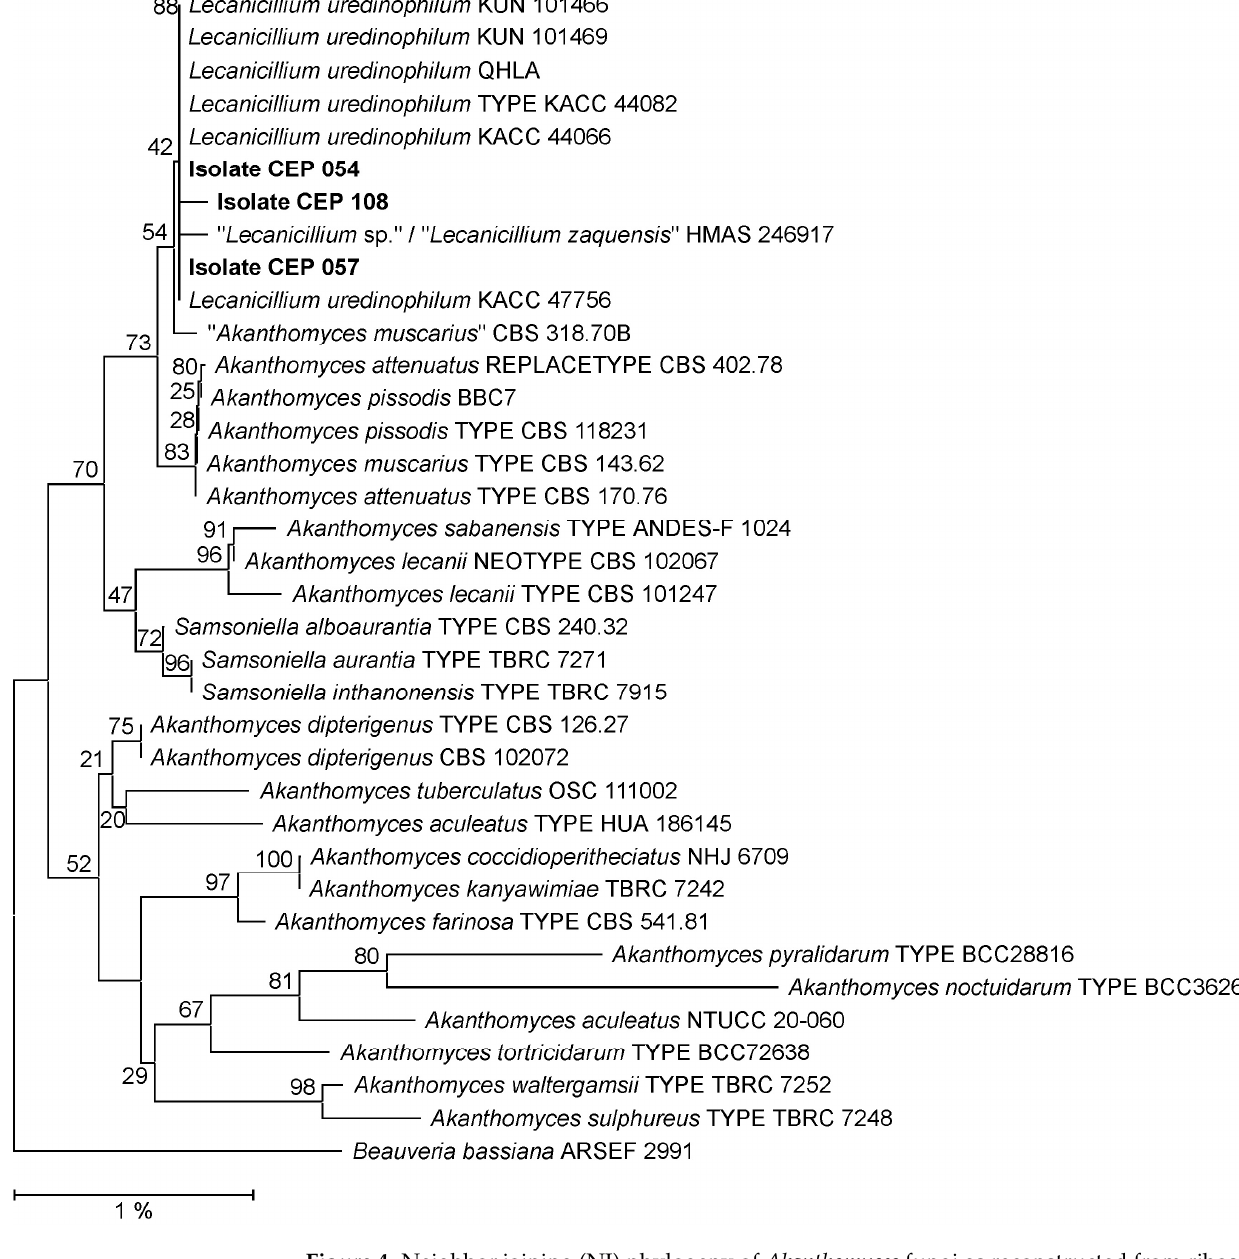
Figure 4. Neighbor joining (NJ) phylogeny of Akanthomyces fungi as reconstructed from ribosomal RNA large subunit (LSU) nucleotide sequences. Terminal branches are labeled by genus, species and strain designations; “TYPE” indicates specific type strains. Designations of fungal isolates from Argentina are shown in bold face; designations in quotation marks indicate non-reference sequences identified by data mining. Numbers on internal branches indicate bootstrap support percentages. The size bar corresponds to 1% sequence divergence with respect to phylogram branch lengths. The LSU sequence from the fungal entomopathogen Beauveria bassiana (Hypocreales; Cordycipitaceae) has been used as the outgroup.